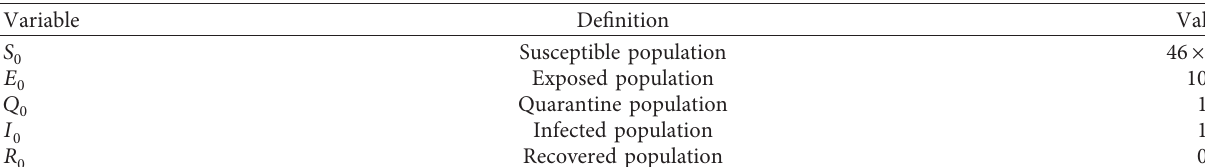
Table 2: Initial conditions.